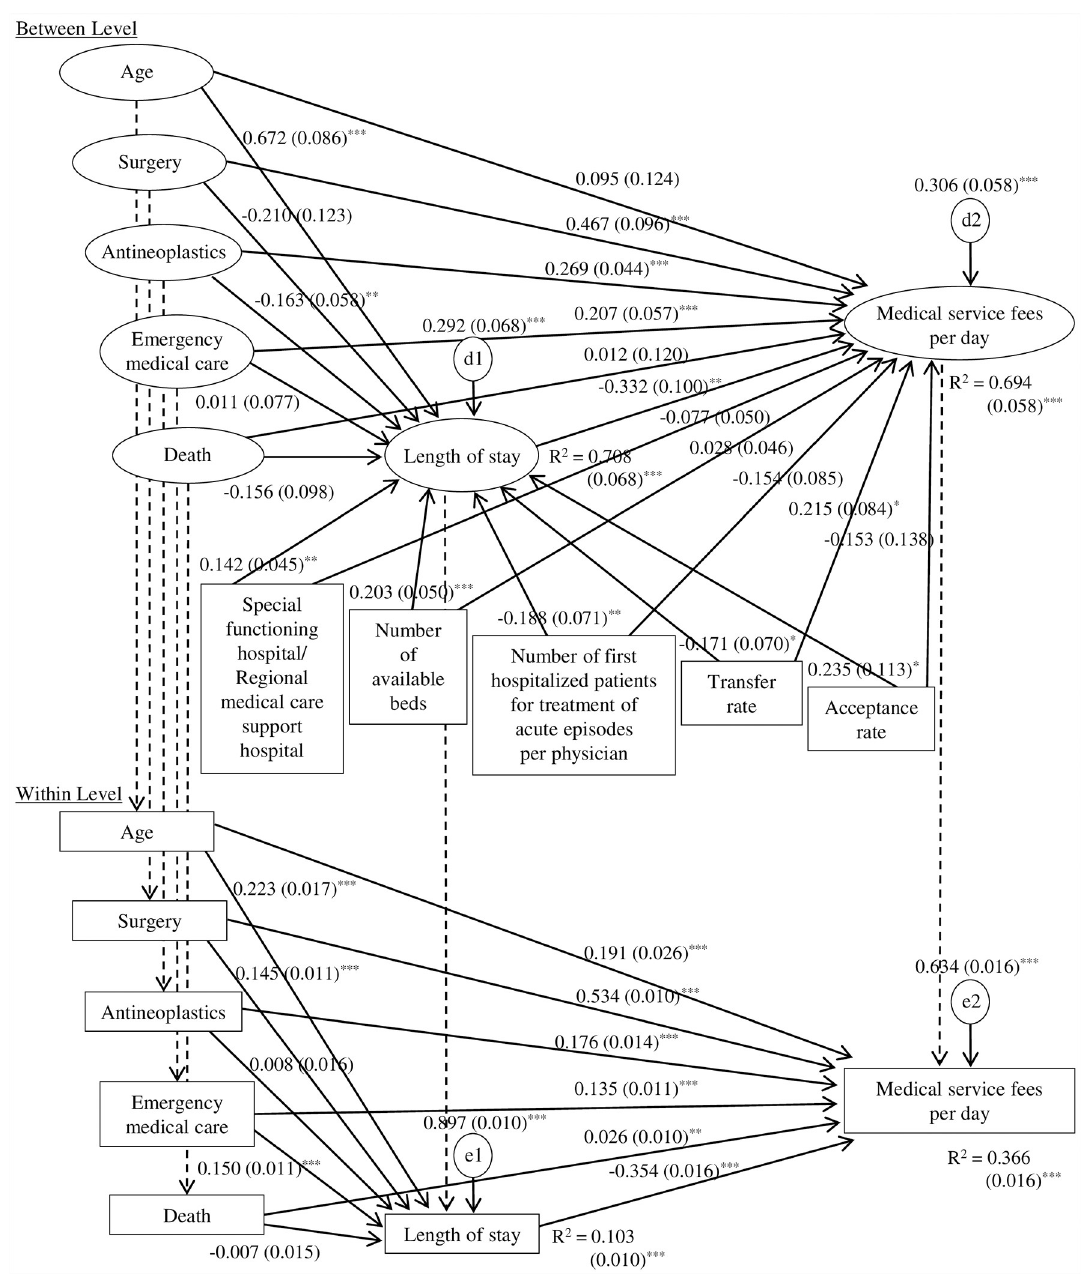
Fig 3. Path showing the relationship between each variable with the standardized coefficients using multilevel structural equation modeling. Estimate (S.E.), � P < .05, �� P < .01, ��� P < .001. Note. Medical service fees per day and LOS were converted to their natural